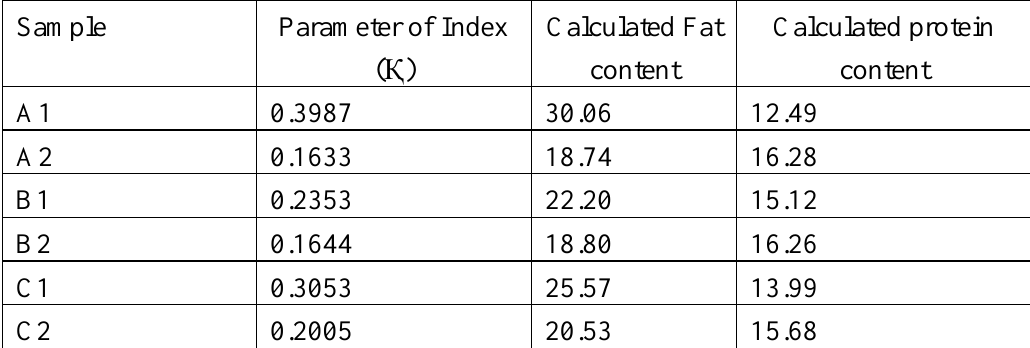
Table 8. Estimation of fat and protein